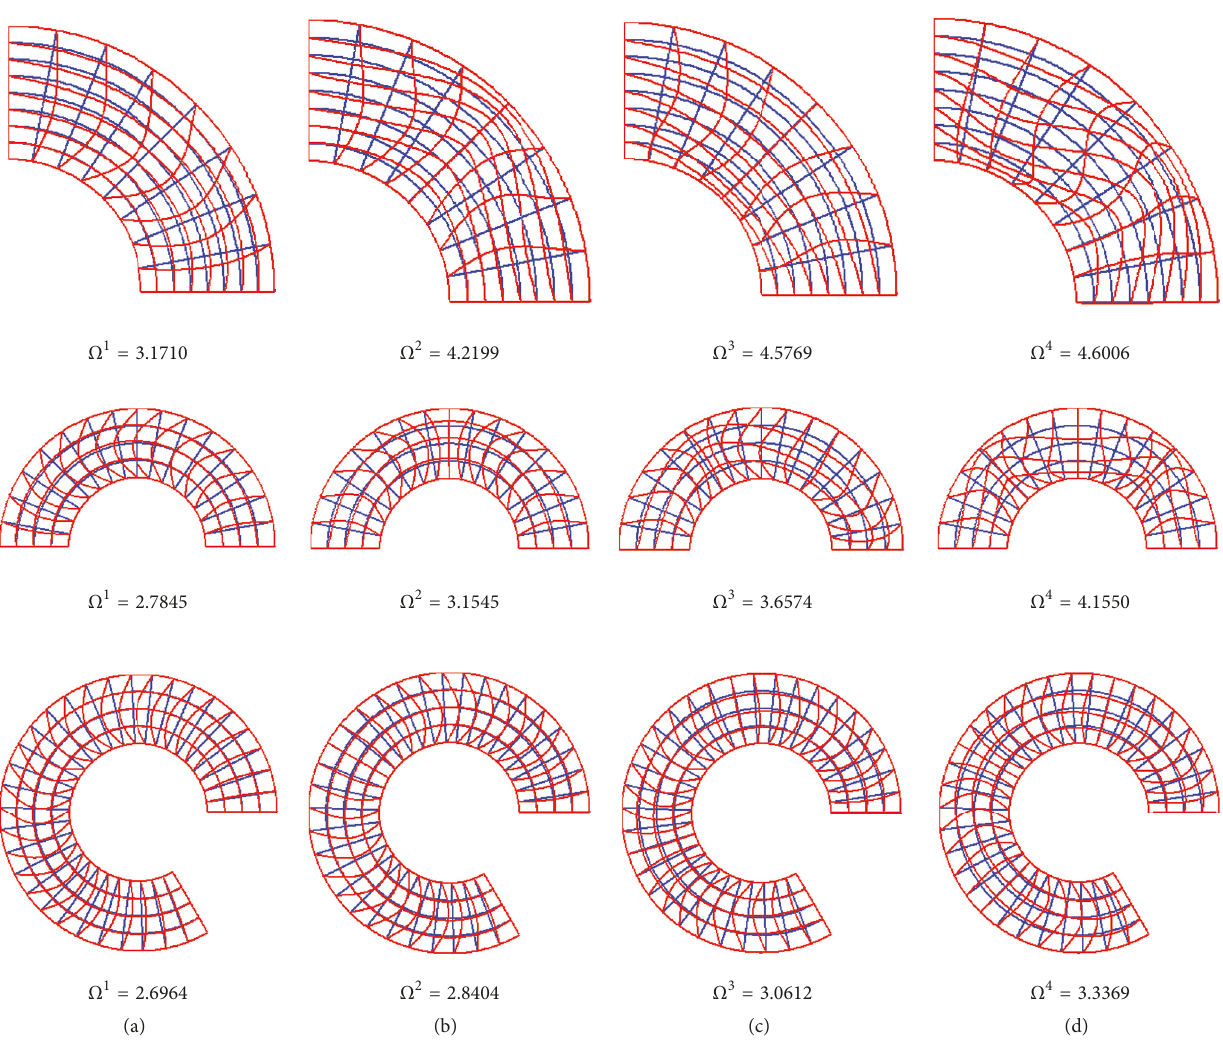
Figure 5: The first four mode shapes of CCCC annular sector plate ( 𝑅 0 /𝑅 1 = 0.5 ) with different sector angles, that is, 𝜙 = 90 ∘ , 180 ∘ , and 300 ∘